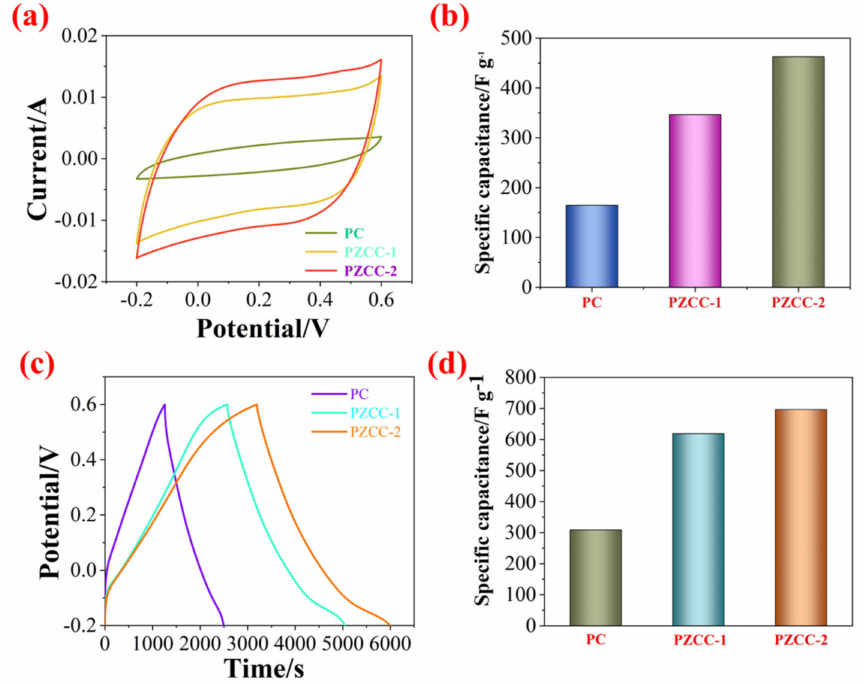
Figure 7. ( a ) Comparative CV profiles of PC, PZCC-1, and PZCC-2 at a scan rate of 5mV · s − 1 , ( b ) specific capacitance of PC, PZCC-1, and PZCC-2 at a current density of 5 mV − 1 , ( c ) comparative GCD profiles of PC, PZCC-1, and PZCC-2 at a current density of 0.2 A · g − 1 , and ( d ) specific capacitance of PC, PZCC-1, and PZCC-2 at a current density of 0.2 A · g − 1